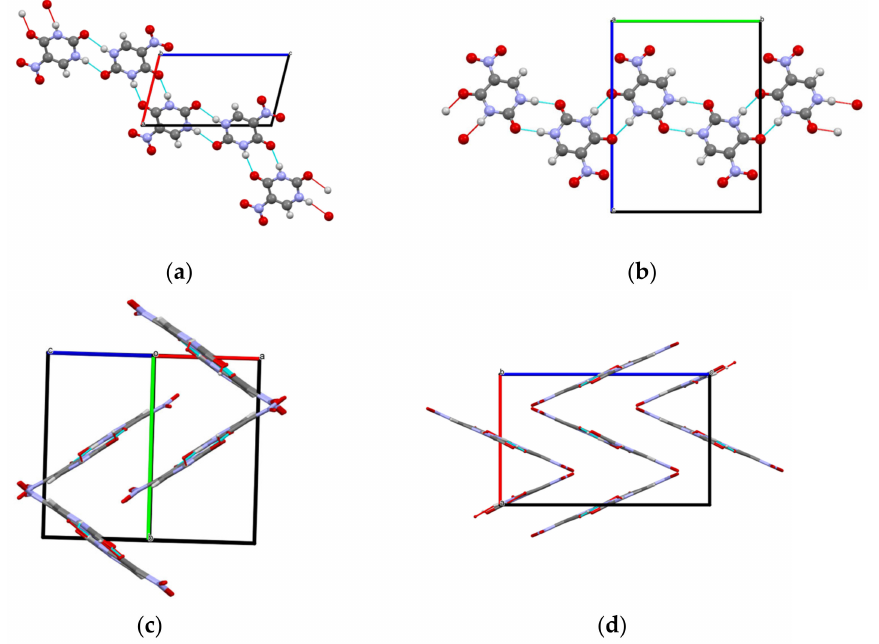
Figure 4. ( a ) H-bonded chain in (I). ( b ) H-bonded chain in (II). ( c ) Chain packing in (I). ( d ) Chain packing in (II)